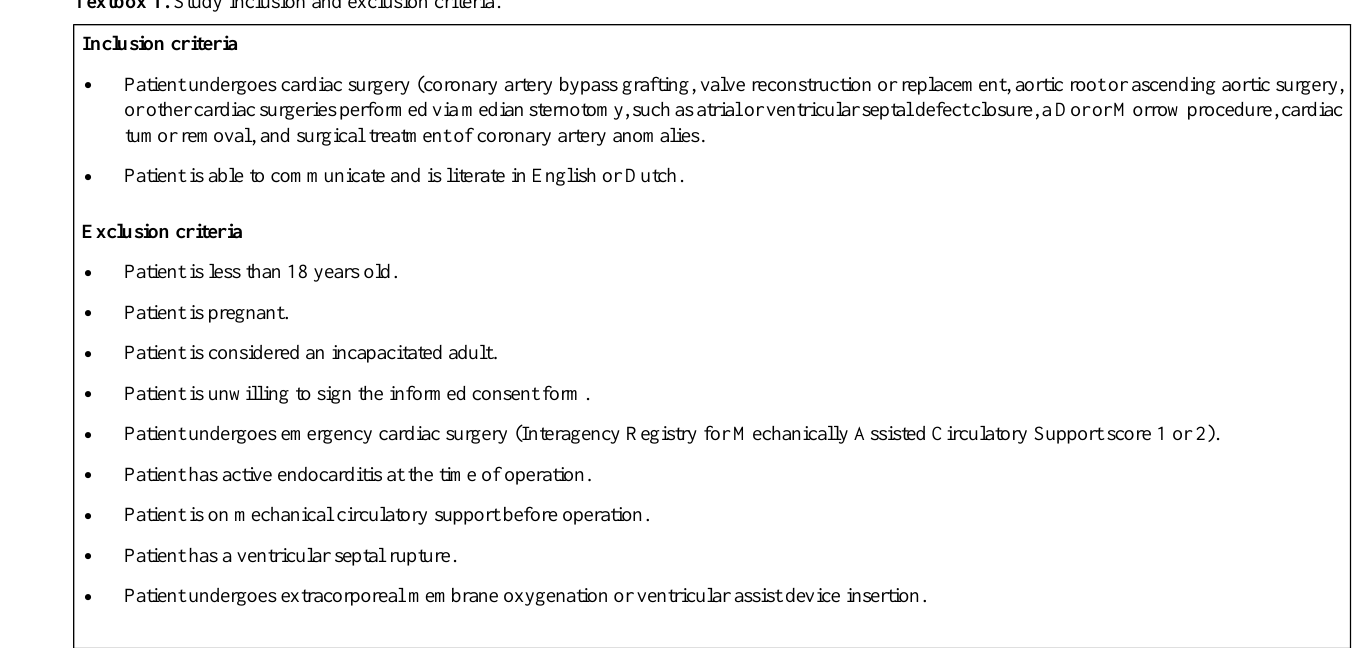
Textbox 1. Study inclusion and exclusion